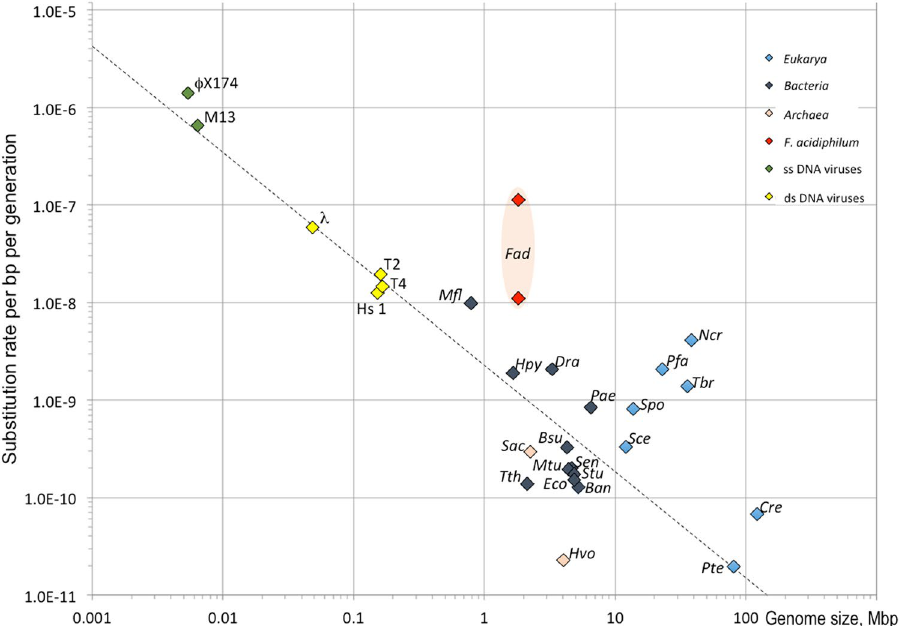
Figure 3. Single-nucleotide mutations accumulated during cultivation of F . acidiphilum Y T . Base-substitutional mutation rates per site per generation plotted vs genome sizes. The data on mutation rates of unicellular organisms and viruses and the regression plot (log 10 u = − 8.66–1.096log 10 G, where u and G are mutation numbers and genome size, respectively) are taken from 29 . Single-stranded DNA viruses: φ X174, phage phi 174; M13, phage M13. Double-stranded DNA viruses: φ , phage lambda; T2, phage T2; T4, bacteriophage T4; Hs 1, Herpes simplex virus. Bacteria: Bsu , Bacillus subtilis; Ban , Bacillus anthracis; Dra , Deinococcus radiodurans; Hpy , Helicobacter pylori; Mfl , Mesoplasma florum ; Mtu , Mycobacterium tuberculosis; Pae , Pseudomonas aeruginosa; Sen , Salmonella enterica; Stu , Salmonella typhimurium; Tth , Thermus thermophilus . Archaea: Fad , Ferroplasma acidiphilum; Hvo , Haloferax volcanii; Sac , Sulfolobus acidocaldarius . Eukarya: Cre , Chlamydomonas reinhardtii; Ncr , Neurospora crassa; Pfa , Plasmodium falciparum; Sce , Saccharomyces cerevisiae; Spo , Schizosaccharomyces pombe; Tbr , Trypanosoma brucei; Pte , Paramecium tetraurelia . Pink area reflects the distribution of mutation rates in Ferroplasma with the higher point value corresponding to all detected base substitutions in the strain cultured for ~550 generations as compared with the original genome, and lower value representing the most conservative mutation rate prediction (all mutations with frequency values < 5% and SNPs in the original genome were